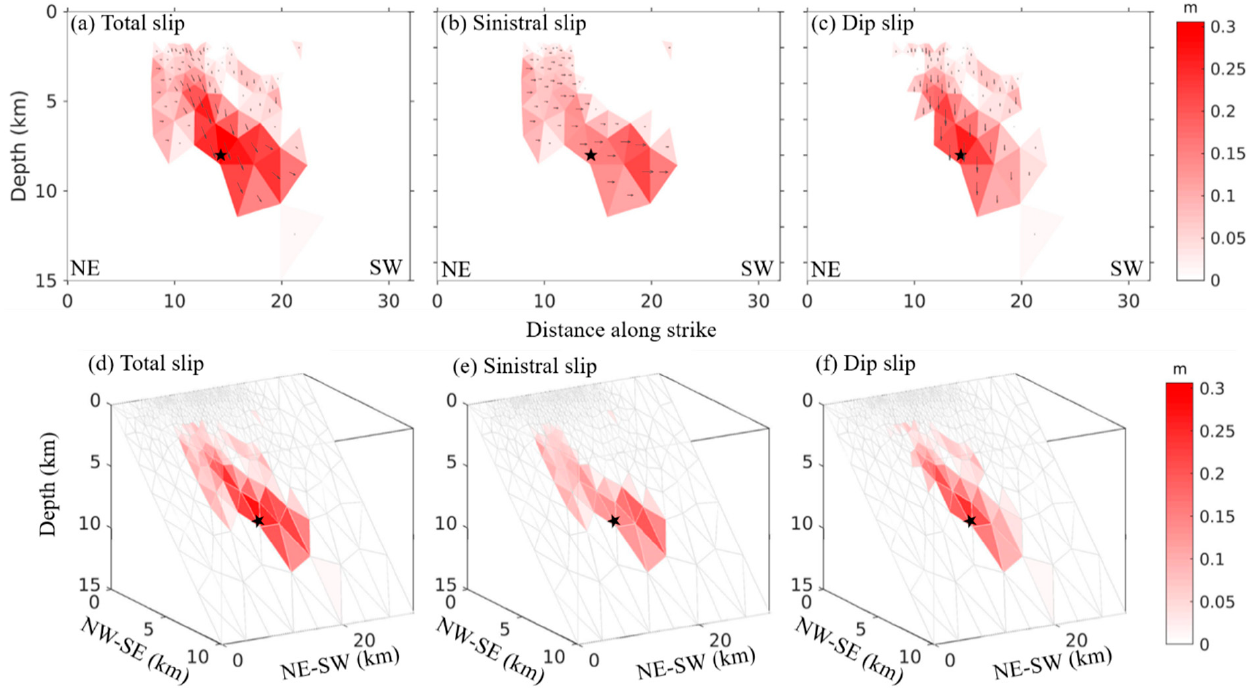
Figure 6. Distributed coseismic slip. ( a ) Total coseismic slip; ( b ) sinistral slip component; and ( c ) dip-slip component. Black stars represent the hypocenter of the 2021 Mw 5.7 Nagqu earthquake estimated in this study based on InSAR data. Black arrows indicate the slip vector. ( d – f ) are 3D views of ( a – c ), respectively.